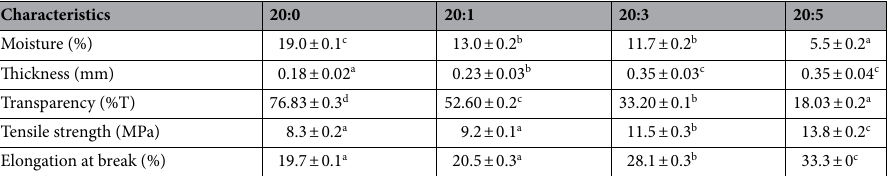
Table 2. Characteristics of the keratin-starch bio-composite films. Results are means ± SD of triplicate determinations. Values in the same row carrying different alphabets are significant ( p < 0.05). Note: 20:0, 20:1, 20:3, and 20:5 = starch/keratin ( v / v ).